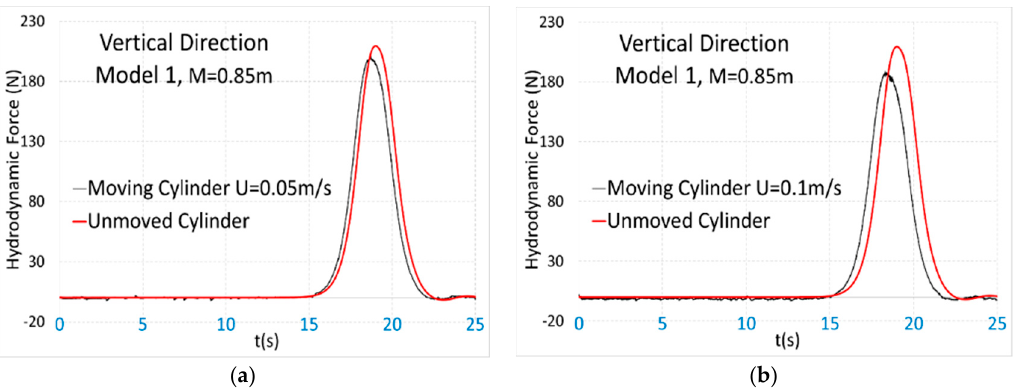
Figure 19. The time variation of the hydrodynamic forces for model 1. ( a ) The comparison between the unmoved cylinder (red line) and the moving cylinder at U c = 0.05 m/s. ( b ) The comparison between the unmoved cylinder (red line) and the moving cylinder at U c = 0.1 m/s.